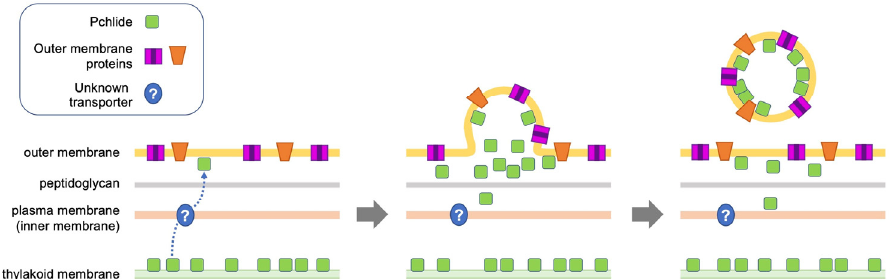
Figure 9. Model of EV formation in YFC2 cells. Pchlide molecules accumulated in the thylakoid membrane are transported to the periplasm by the action of an unknown transporter located in the plasma membrane. The abnormal accumulation of Pchlide in the periplasm may cause an increase in the periplasm pressure or weaken the interaction between the outer membrane and peptidoglycan layer, thus stimulating EV formation.